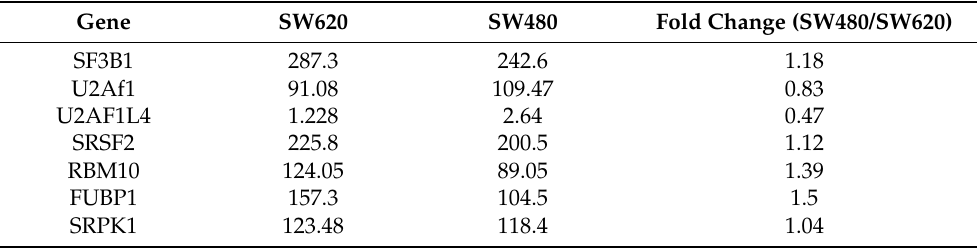
Table 3. RNA-Seq analysis of fold changes in splicing factor genes between metastatic (SW620) and primary (SW480) colorectal cancer cell lines. (Values are normalized FPKM values from RNA- Seq